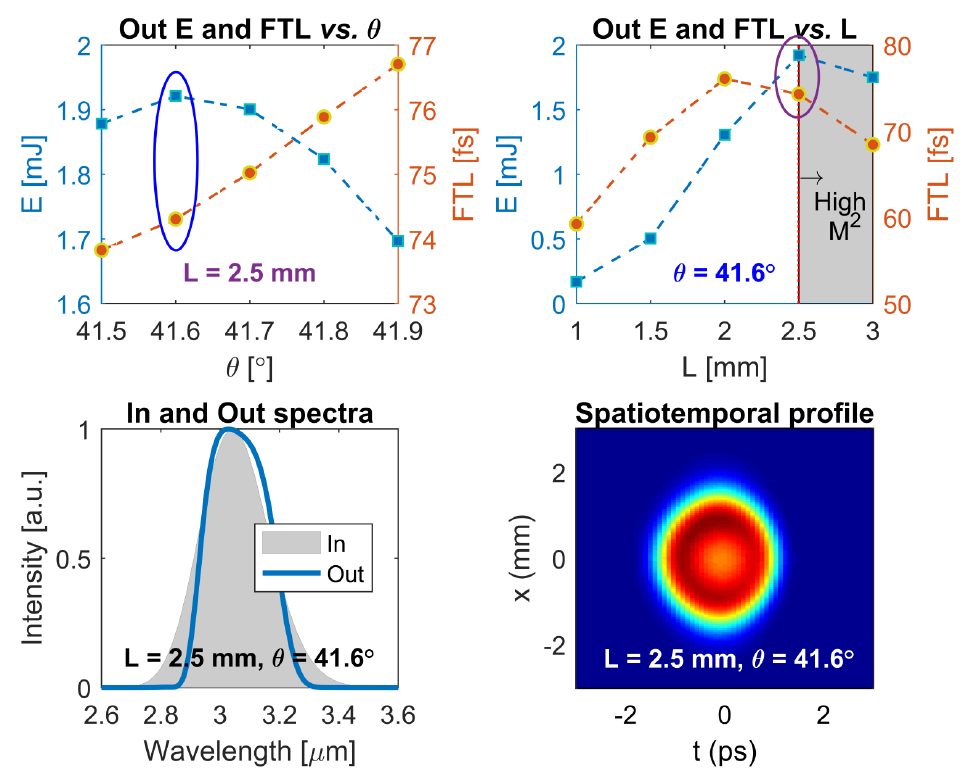
Figure 1. Results for a single collinear KTA-based amplification stage. Top : output energy and compressed pulse duration vs. ( left ) phase matching angle θ for L = 2.5 mm and ( right ) crystal length L for θ = 41.6 ◦ . The circled points mark the optimum combination of both parameters. Bottom left : Input ( shaded ) and output ( blue ) spectra for the optimal parameters. Bottom right : Spatiotemporal profile of the optimized output pulse with 1.92 mJ and 74 fs